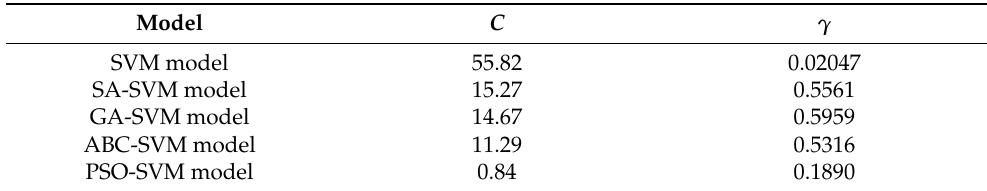
Table 3. The comparison of model parameters.